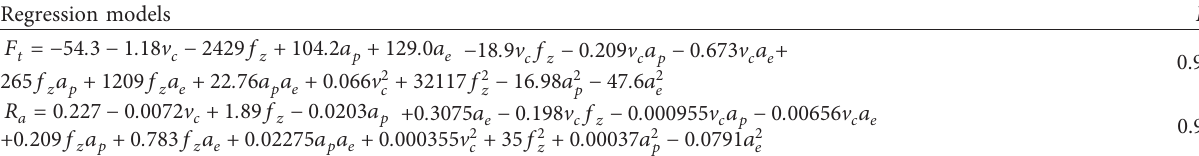
Table 5: Regression models and R 2 values.